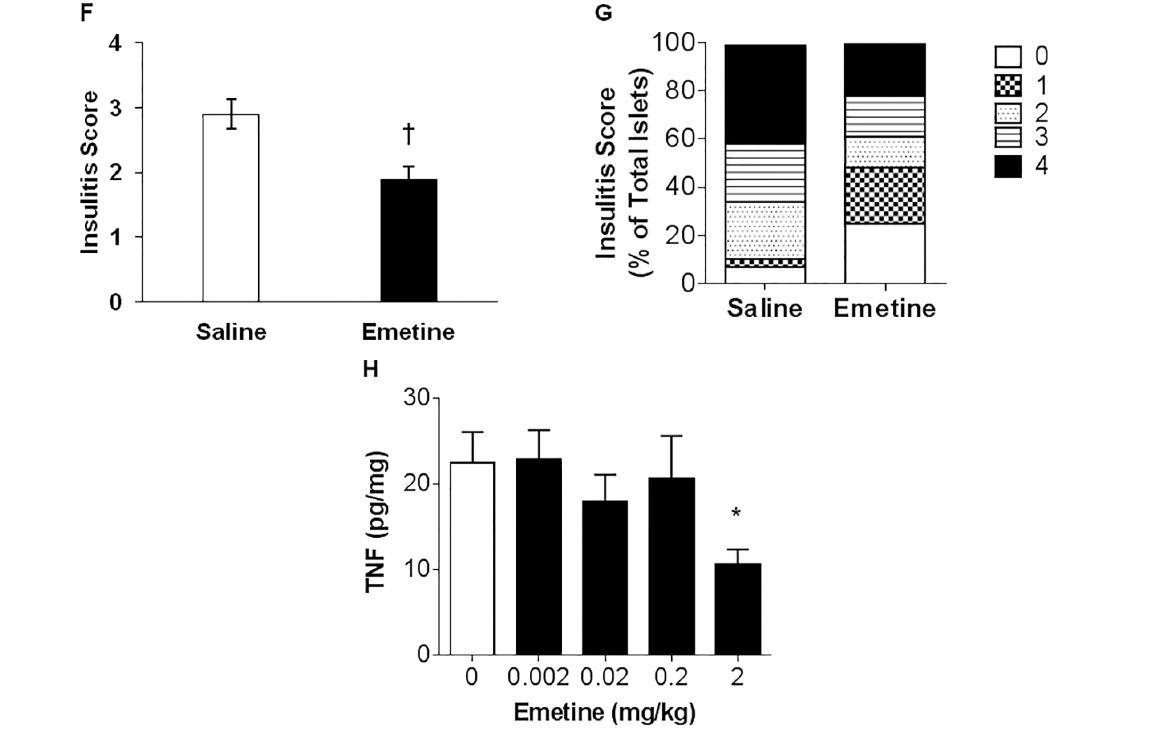
suggests that PEDF induces the activation of macrophages and promotes the release of cytokines through P38MAPK and ERK signaling, independent of